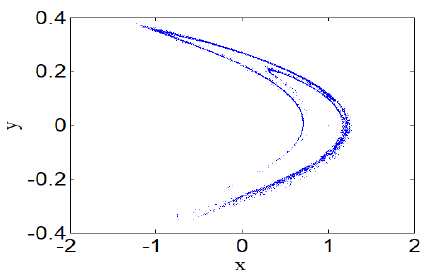
Figure 1. The phase space diagram of the fractional-order Henon map with x 0 = 0, y 0 = 0, α = 0.99, a = 1.4 and b = 0.3.